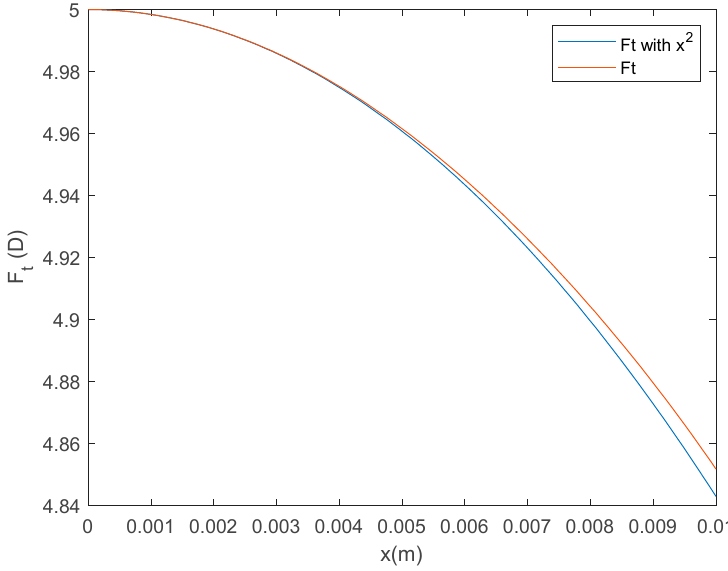
= 37 D, computed 2